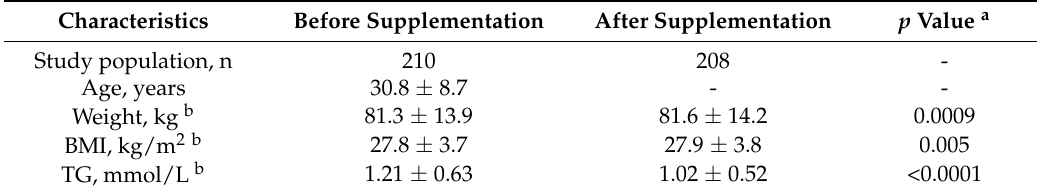
Table 1. Characteristics of the study sample before and after